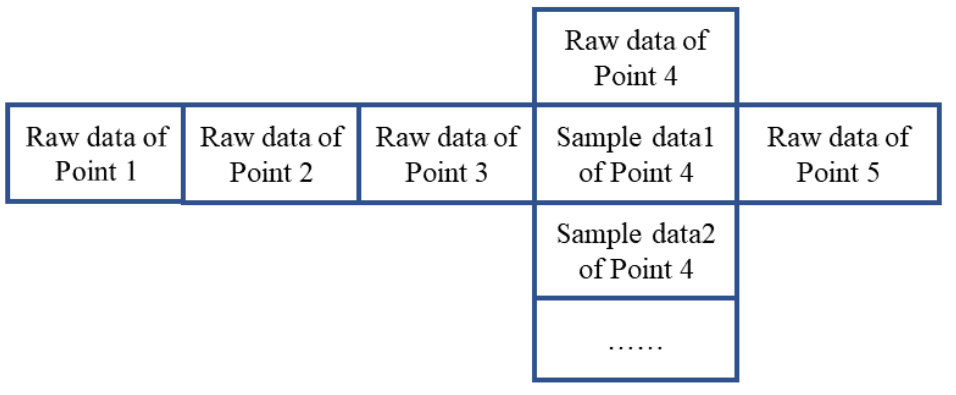
Figure 16. Training the dataset at a certain point in a single-variable approach.